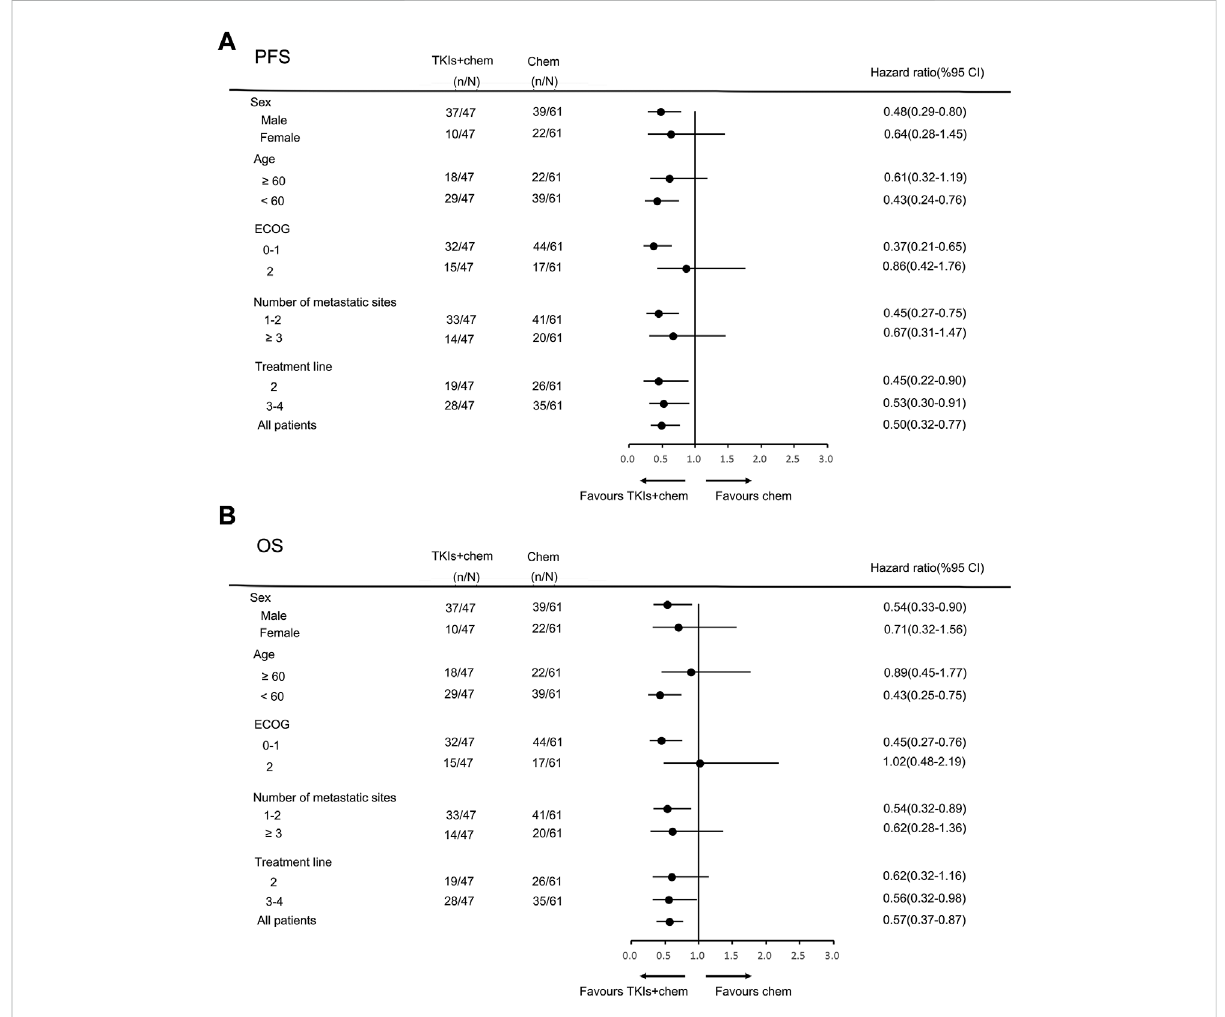
FIGURE 4 Subgroup analysis of PFS (A) and OS (B) according to clinicopathologic factors in TKIs + chemotherapy